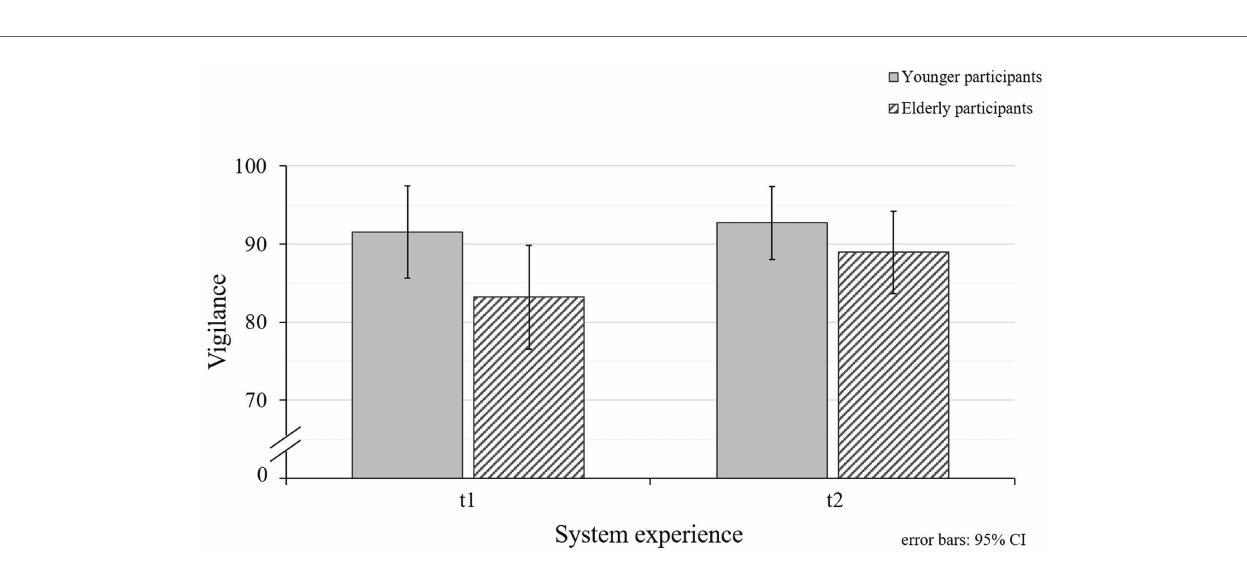
FIGURE 8 | Mean values for younger and elderly participants’ feeling of safety ratings during the interaction for the different points of measurement (t1 = valid system functions; t2 = valid and invalid system functions). Higher values represent higher feeling of